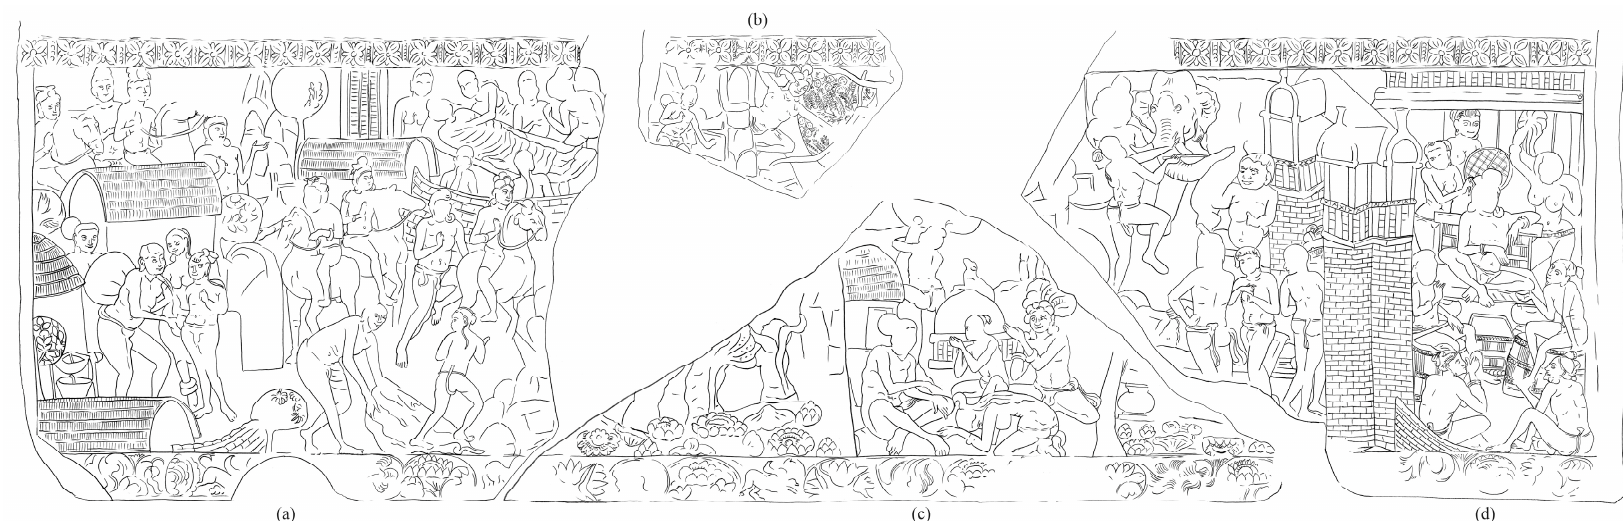
Figure 4. Reconstructive drawing of four fragments of a coping stone, Amaravati, Chennai Government Museum, nos. 53, 54, 75 and 124 © Monika Zin. (a) Chennai Government Museum, no. 124. (b) Chennai Government Museum, no. 53. (c) Chennai Government Museum, no. 54 (d) Chennai Government Museum, no.